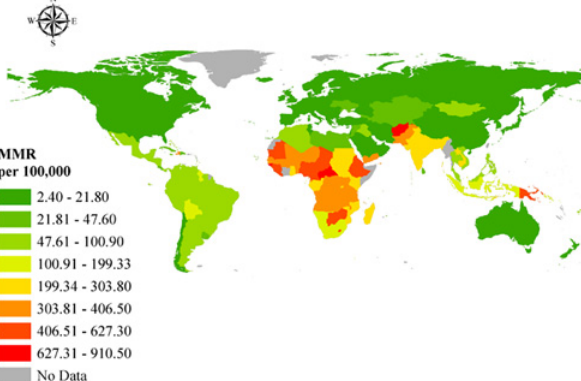
Fig 3. Geographic representation of the MMR. Open source polygon feature data for the maps were downloaded [20] and, subsequently, projected using ESRI ArcGIS [21].